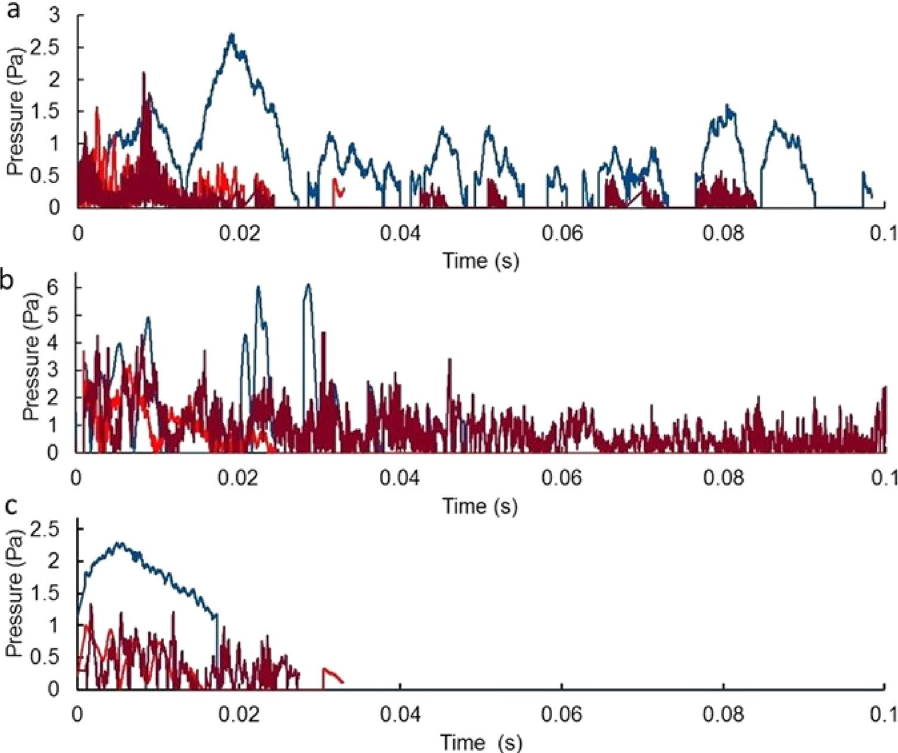
Figure 3. Pressure versus time for 3 longest duration signals recorded on ( a ) 11 May 2019, ( b ) 2 July 2019, and ( c ) 14 September 2019 for sensor a1 (blue), a2 (bright red) and a3 (dark